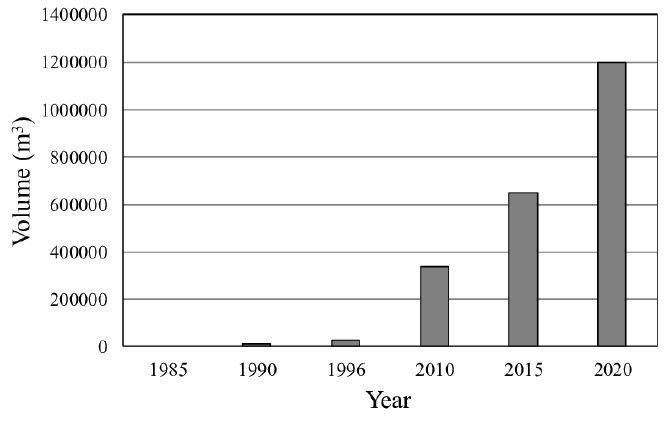
Figure 2. Increase in the volume of cross laminated timber production according to Sandoli et al.